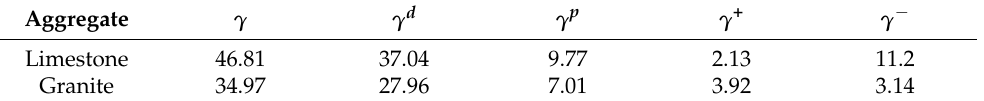
Table 9. Surface free energy of aggregate (mJ/m 2 ).